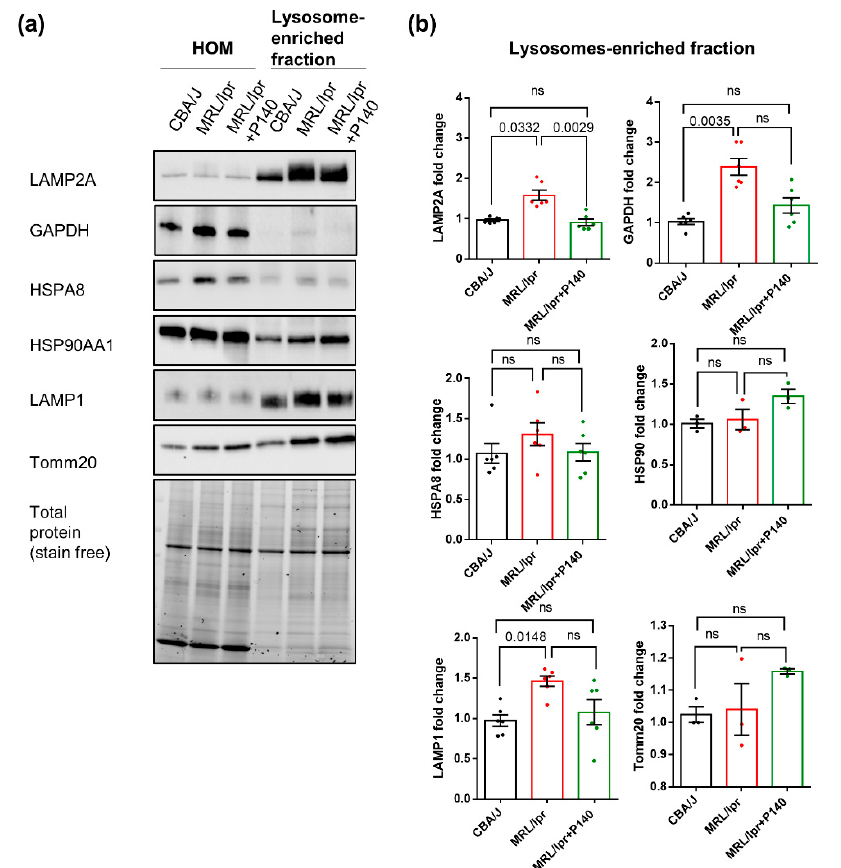
Figure 2. Expression of CMA markers in enriched lysosomal fractions from lupus mice and effects of P140 peptide: Cell homogenates (HOMs) and lysosome-enriched fractions were prepared from splenocytes of CBA/J, MRL/lpr and P140-treated MRL/lpr mice. ( a , b ) The protein expression levels of LAMP2A, GAPDH, HSPA8, HSP90, LAMP1 and Tomm20 were examined by Western blotting. Total protein normalization was used for quantification (stain-free method). n = 6 mice per group with triplicates for each sample. One-way ANOVA Krustal-Wallis test was used to analyze the statistical significance. Error bars are ± SEM. ns means p values > 0.05.